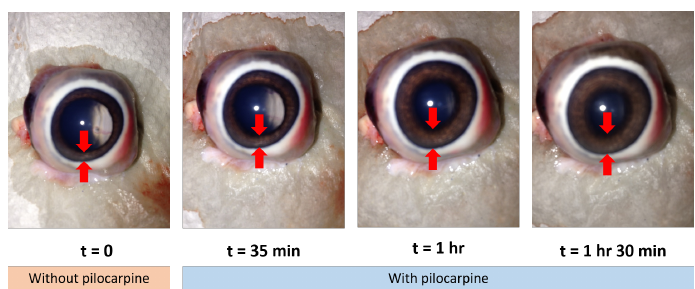
Figure 1. Action of the pilocarpine for the iris